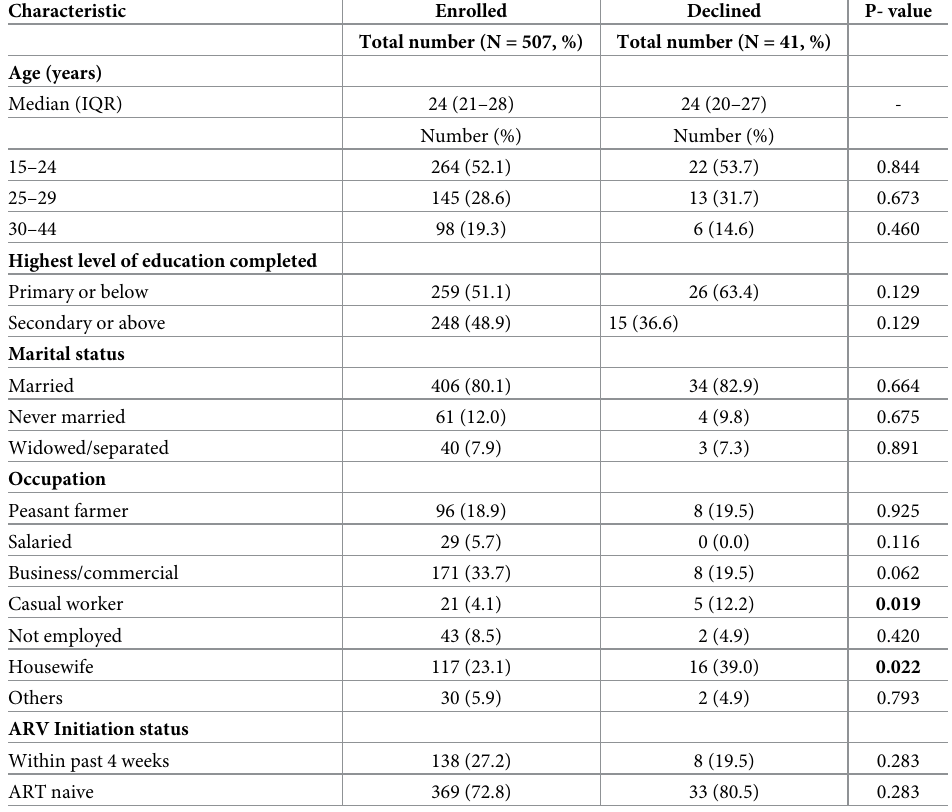
Table 3. Comparison of baseline characteristics of HIV positive pregnant women recruited into the study (N = 507) and those who declined (N =